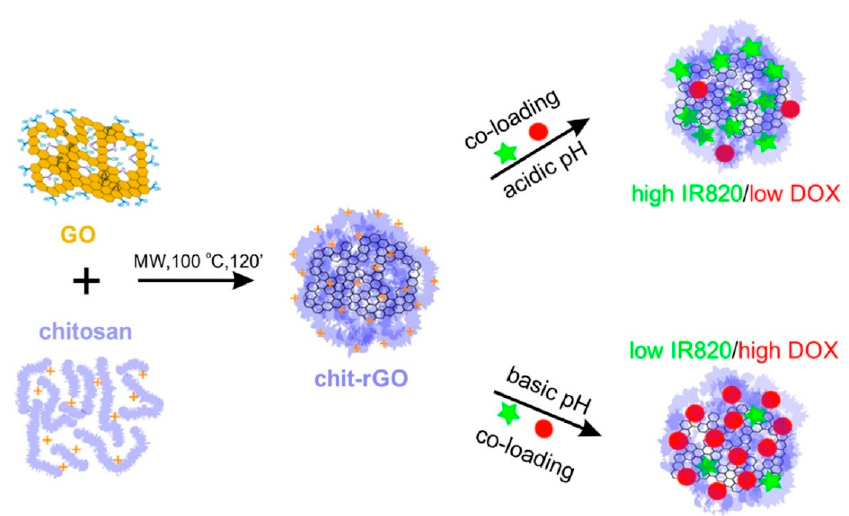
Figure 5. The use of polymeric chitosan in the formulation of a multifunctional chemo-phototherapeutic agent. Chitosan was used as a reducing and stabilizing agent for reduced graphene oxide nanoflakes and also served as a shell to entrap DOX and IR820 dye at different ratios. Reproduced with permission from Reference [122] Copyright © 2019 Elsevier.